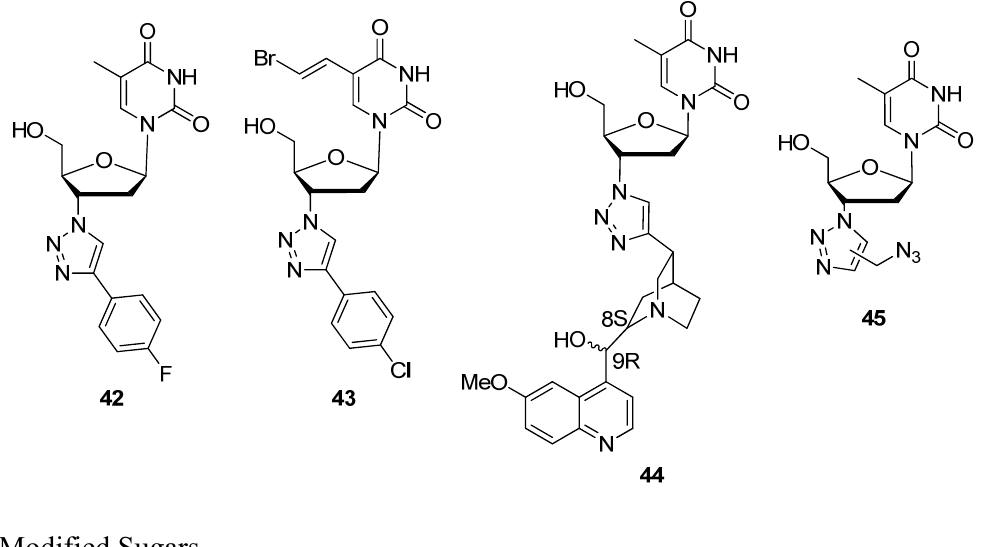
Figure 6. Various C3 ′ -triazole modified 2 ′